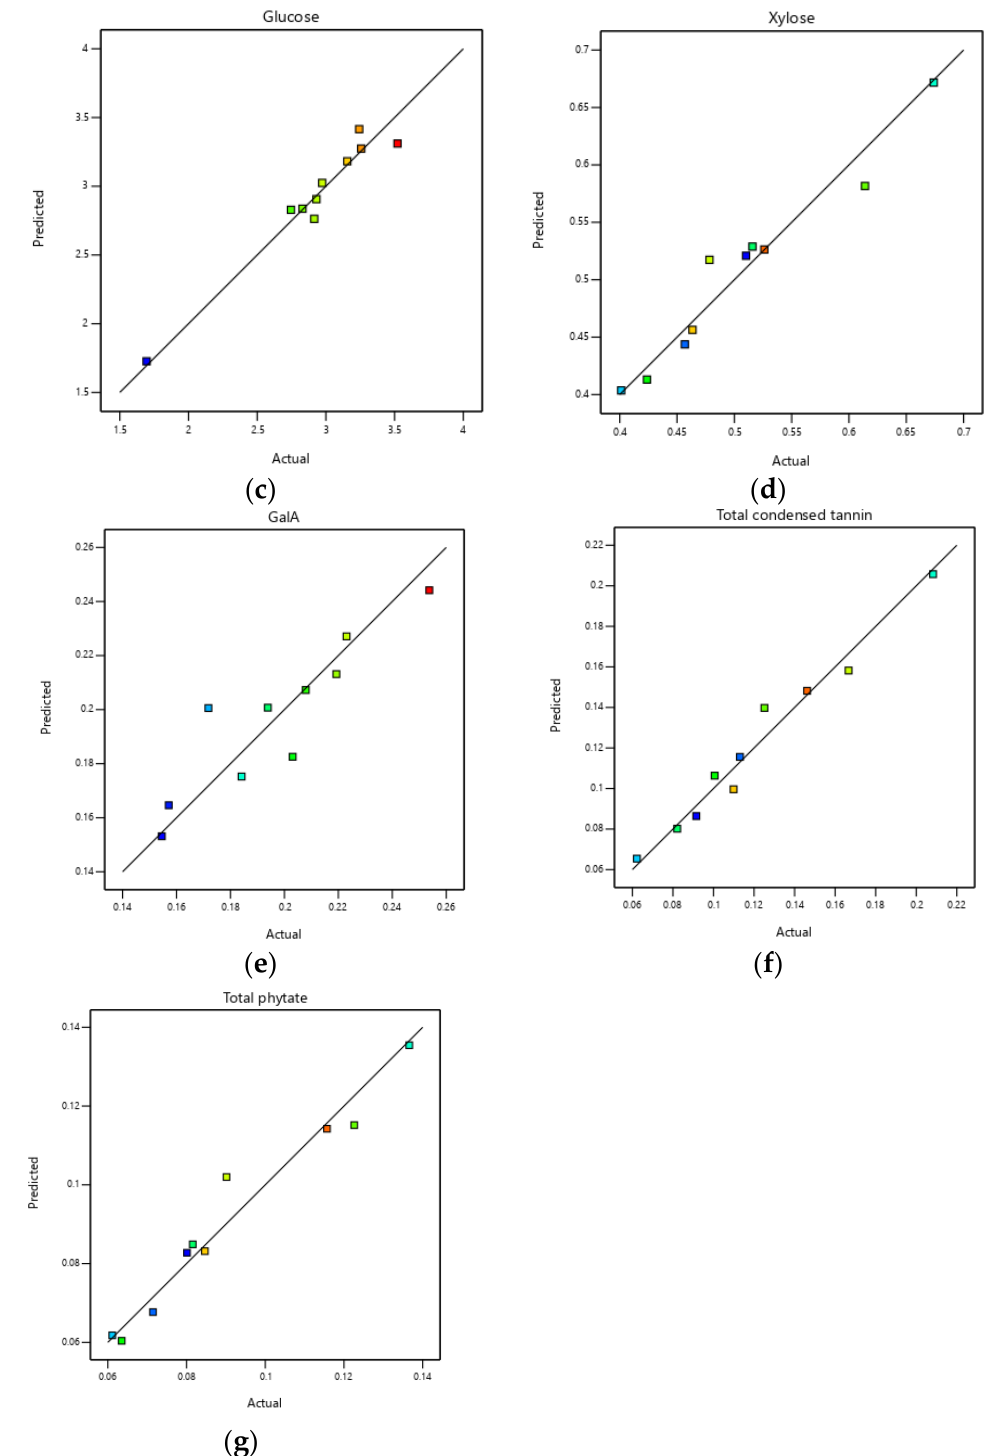
Figure A1. Scatter plots showing the relationship between the predicted and actual values of each response in the regression model: ( a ) TSS, ( b ) reducing sugars, ( c ) glucose, ( d ) xylose, ( e ) GalA, ( f ), total condensed tannins, and ( g ) total phytate.